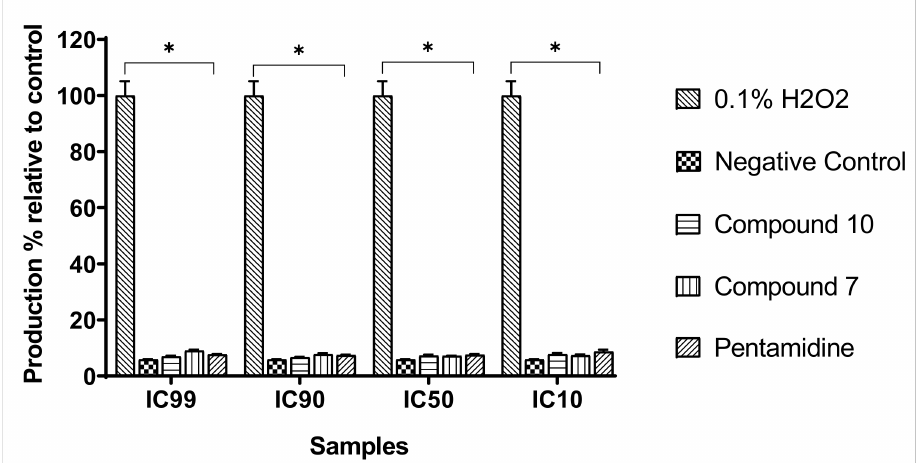
Figure 10. Production of intracellular reactive oxygen species (ROS). Parasites were treated with or without compounds at their respective IC 99 , IC 90 , IC 50 , and IC 10 for 120 min, and ROS production was measured using DCF-DA reagent. H 2 O 2 (0.1%) was included as a positive control and further used to calculate the ROS production percentages. The obtained results are expressed as the mean ± standard deviation of two independent experiments performed in duplicate. * Significant difference at p < 0.05.